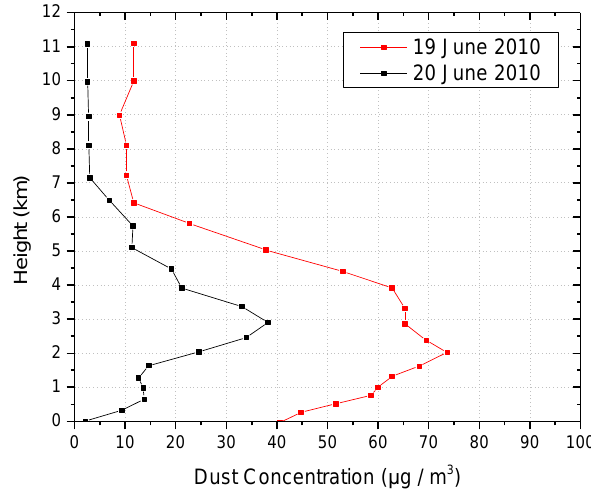
Fig. 7. MFR-7 AOD retrievals at 500nm on 19 and 20 June 2010 at Hydra campaign site. Microtops II AOD retrievals at 1020nm are superimposed. Figure 7. MFR-7 AOD retrievals at 500 nm on 19 and 20 June 2010 at Hydra campaign site. 4 Microtops II AOD retrievals at 1020 nm are superimposed. 5